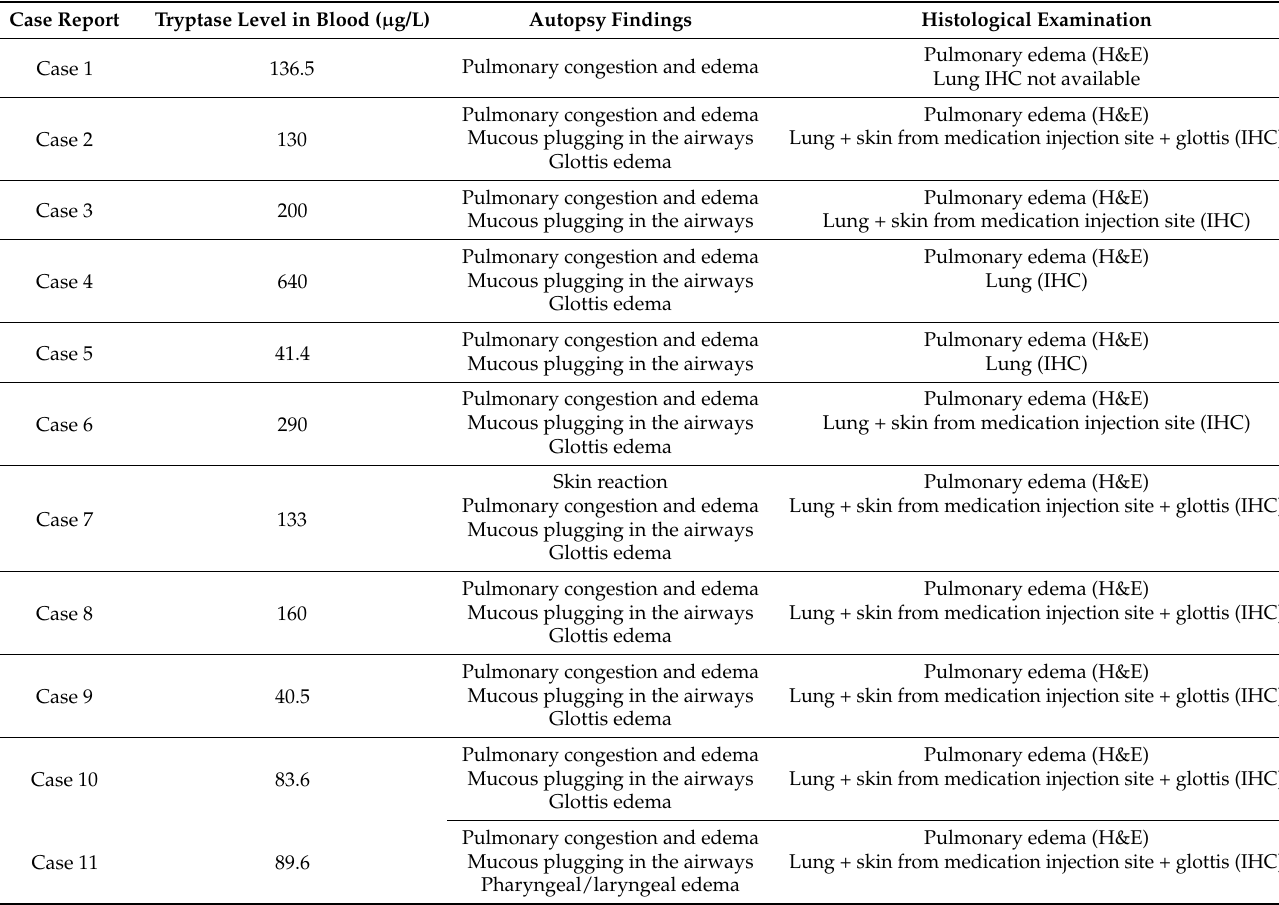
Table 2. Concentration of total serum tryptase, autopsy findings and histological examination. H&E: hematoxylin–eosin; IHC: